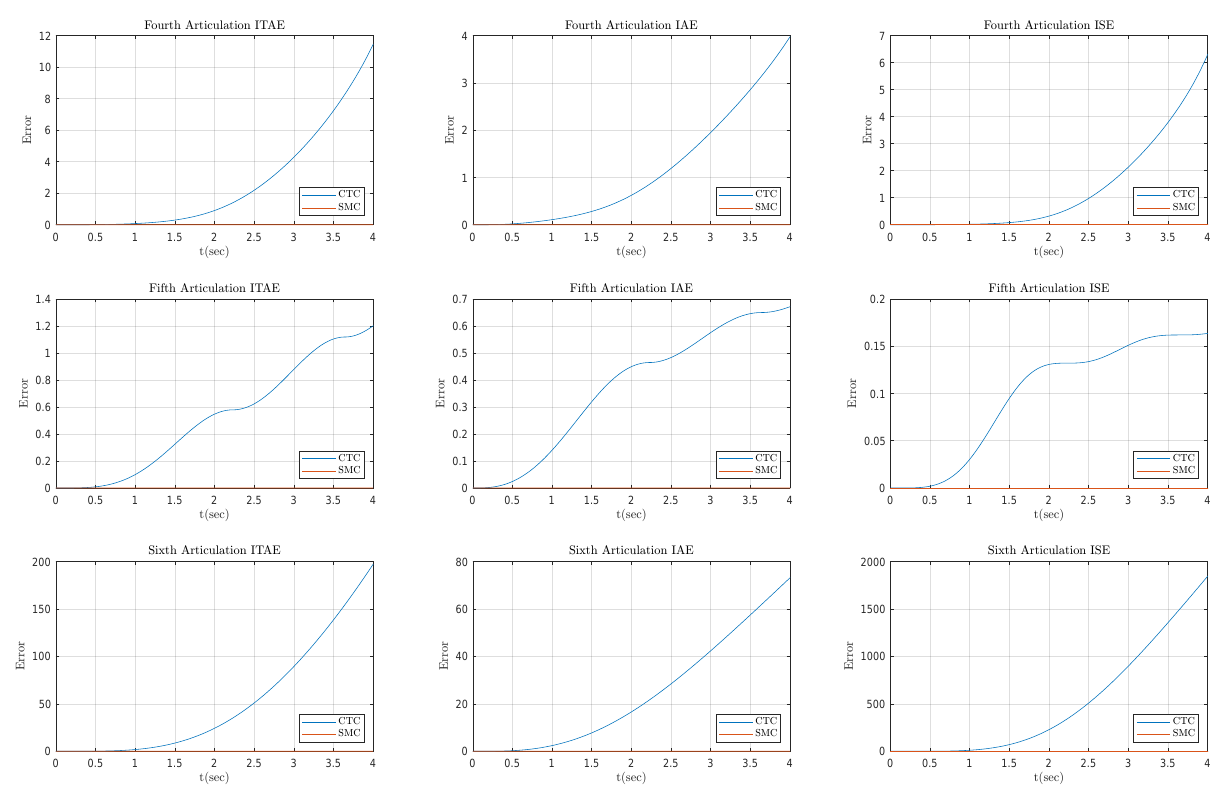
Figure 7. Error performance indexes: ITAE, IAE, and